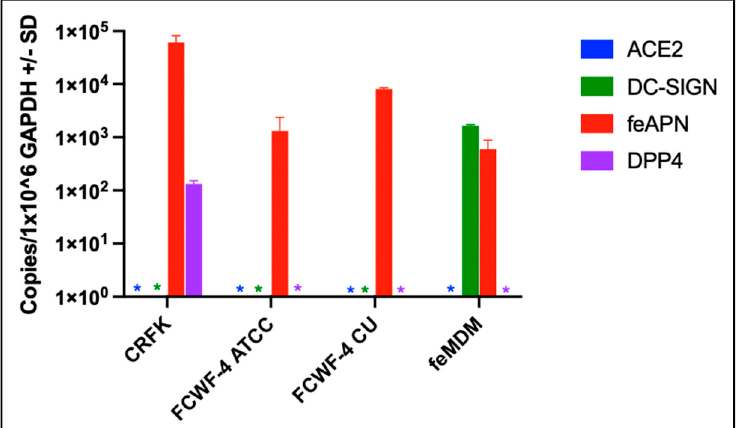
Figure 4. Expression profiles of known coronavirus receptor genes among cell lines permissive to either FIPV I or II tissue-culture-adapted strains, Black I and WSU-79-1146, respectively. Colored asterisks (*) represent undetected gene expression.